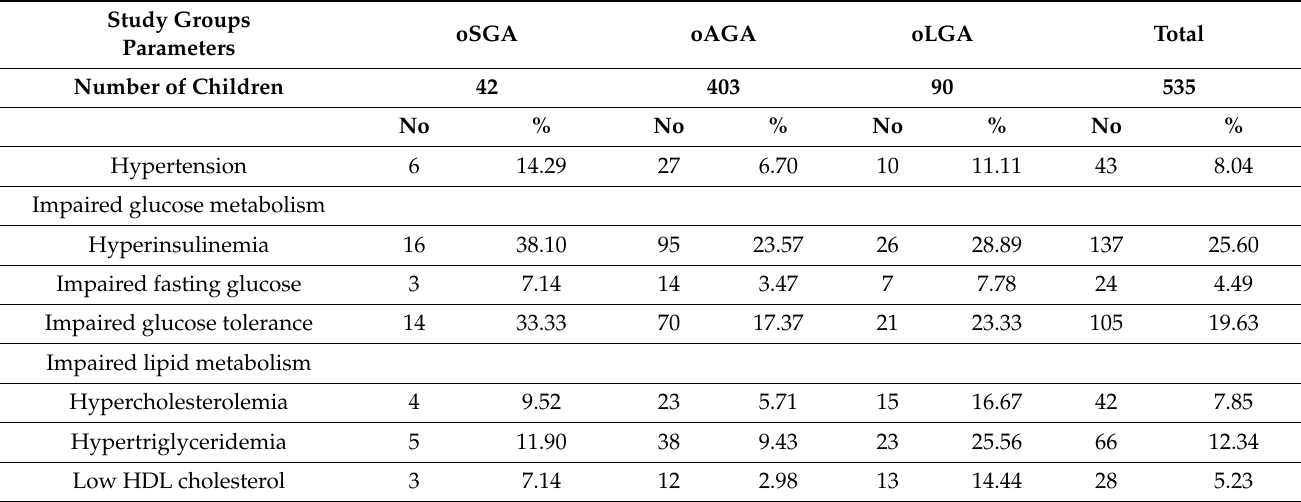
Table 5. Distribution of the individual MetS components in the study